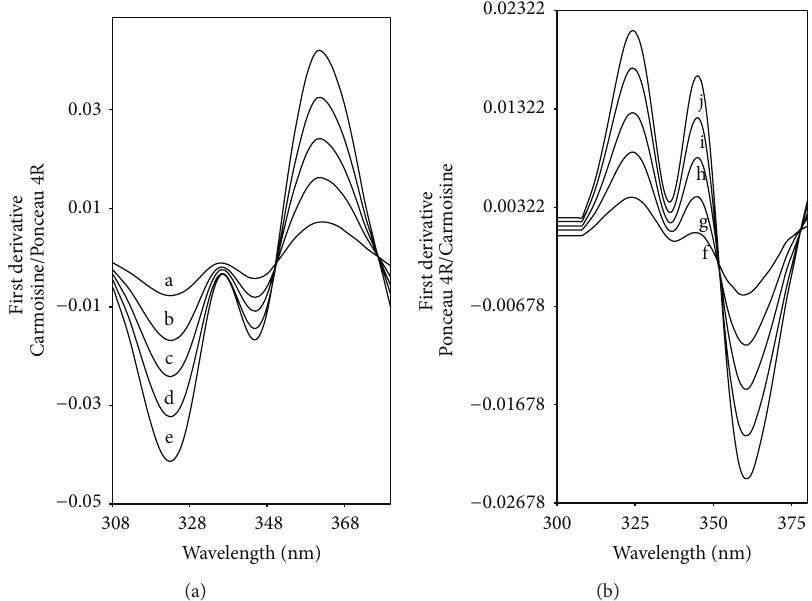
Figure 2: First derivative ratio spectra of Carmoisine (a) and Ponceau 4R (b) for different concentrations (Carmoisine (6 𝜇 gmL −1 Ponceau 4R was used as a divisor); a: 2 𝜇 gmL −1 , b: 4 𝜇 g mL −1 , c: 6 𝜇 g mL −1 , d: 8 𝜇 gmL −1 , e: 10 𝜇 g mL −1 ; Ponceau 4R (6 𝜇 g mL −1 Carmoisine was used